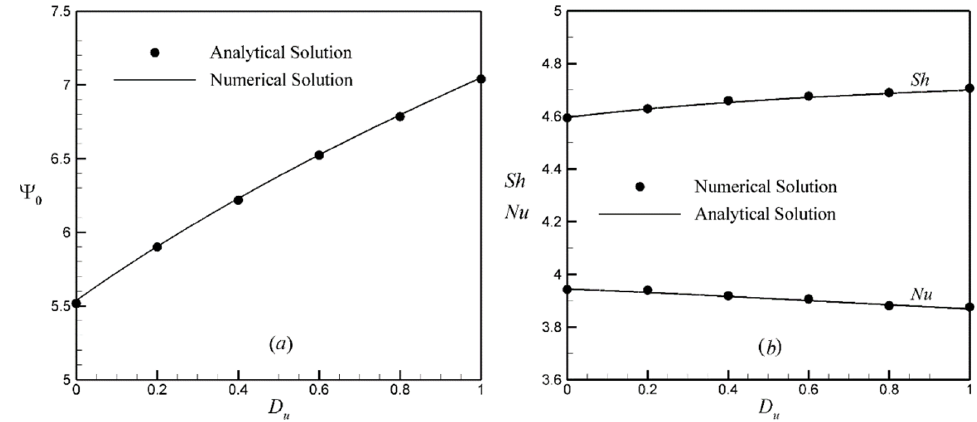
Ψ , D , on ( a ) stream function at the center of the cavity, D , on ( a ) stream function at the center of the cavity, Figure 12. Effect of Dufour parameter, Figure 12. Effect of Dufour parameter, Figure 12. Effect of Dufour parameter, D u , on ( a ) stream function at the center of the cavity, Ψ 0 , u u 0 ( b ) local Nusselt number, Nu , and local Sherwood number, Sh , for Da e = 10 − 4 , R T = 10 3 , Le = 2, ( b ) local Nusselt number, Nu , and local Sherwood number, Sh , for ( b ) local Nusselt number, Nu , and local Sherwood number, Sh , for ξ = 0, ε = 1 and S r = 0. Figure 13a,b exemplify the effects of the Soret and Dufour parameters on the thresholds of bifurcations R sub , R sup and R Hopf for Da e = 10 − 4 , Le = 2, ξ = 0 and ε = 1. The critical TC TC TC Rayleigh numbers for the onset of stationary convection, R sup , and for the onset of Hopf TC bifurcation, R Hopf , are predicted by the linear stability theory. However, the onset TC